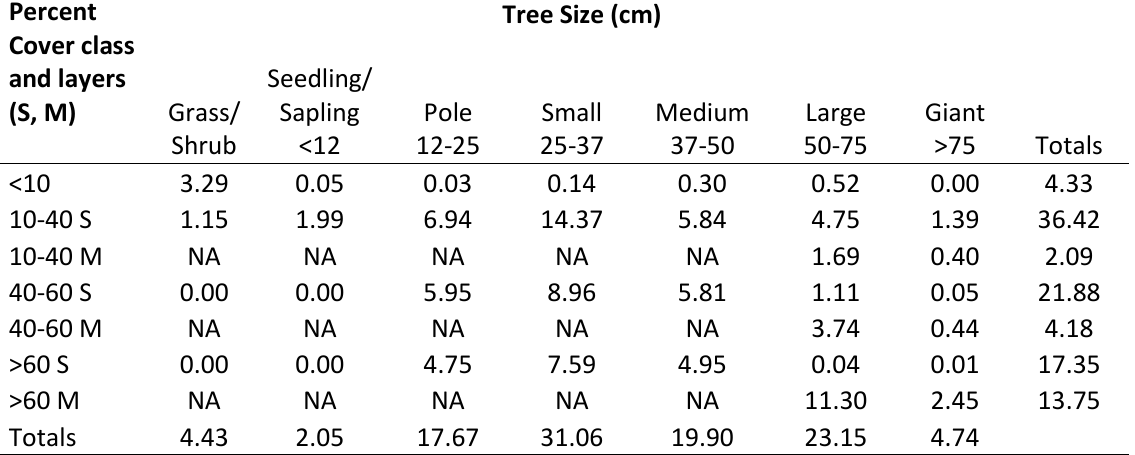
Table A1.1 Percent of study area in vegetation structure (cover, tree size and layers (single or multiple) used in state and transition models at year 0. S stands for single story and M for multi- story.